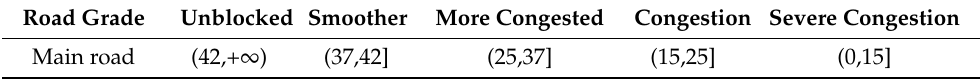
Table 1. Judgment Standard Table of Average Travel Speed of Road Section.